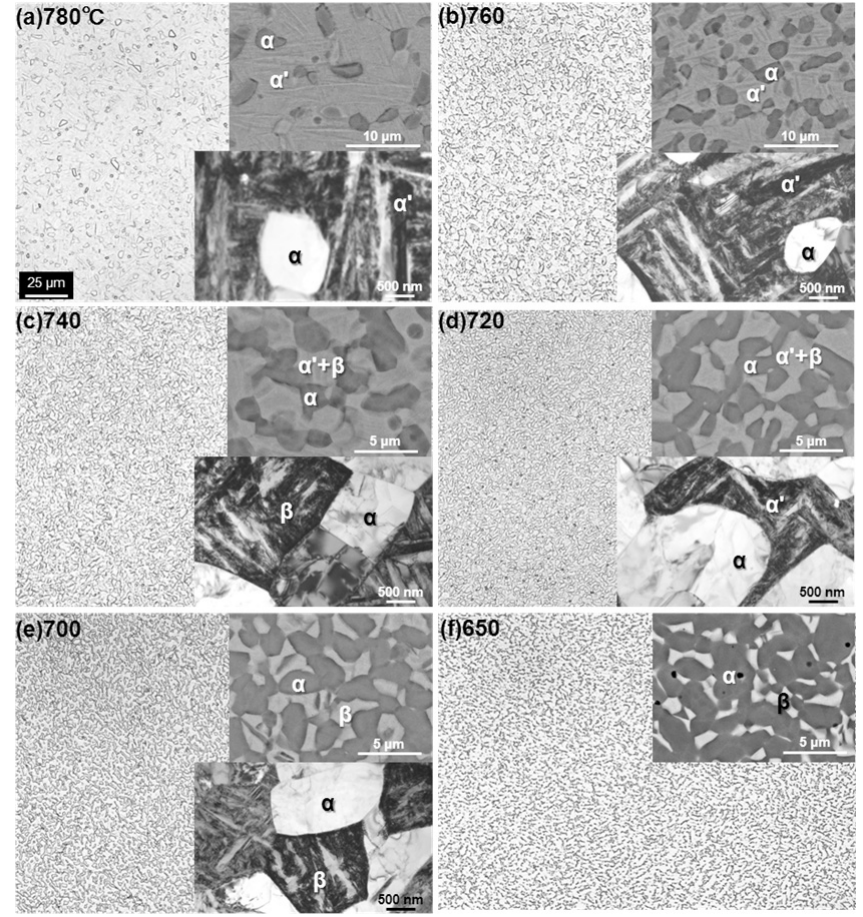
Figure 4. Comparison of optical microscopy, scanning electron microscopy (SEM) and transmission electron microscopy (TEM) images of Ti-15Zr-4Nb-4Ta alloy solution-treated at ( a ) 780; ( b ) 760; ( c ) 740; ( d ) 720; ( e ) 700; ( f ) and 650 °C for 1 h, and then quenched in water.